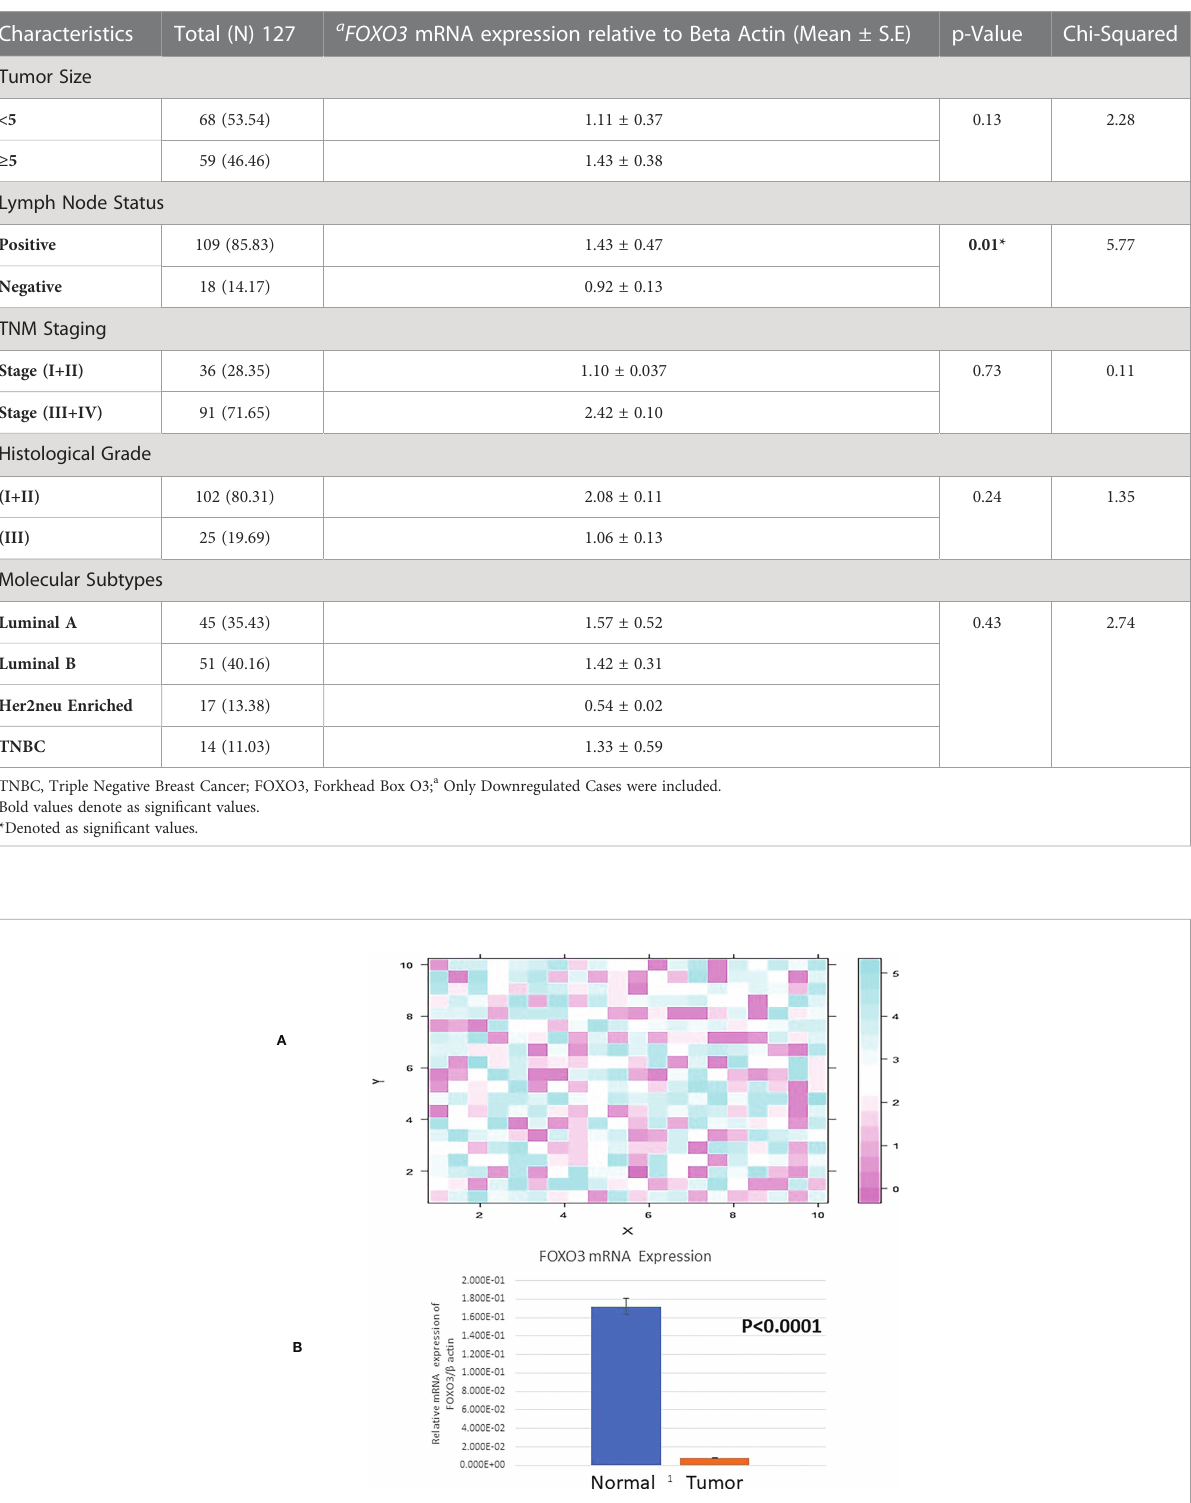
FIGURE 2 (A) Heat Map plot (analyzed by R platform version 3.6.3 64-bit) of FOXO3 mRNA relative expression (fold change) in Breast cancer cases. X-axis depicts D Cq target against Y-axis D Cq control at default parameters. (B) Relative mRNA expression of FOXO3/B ACTIN in Breast tumor and adjacent normal